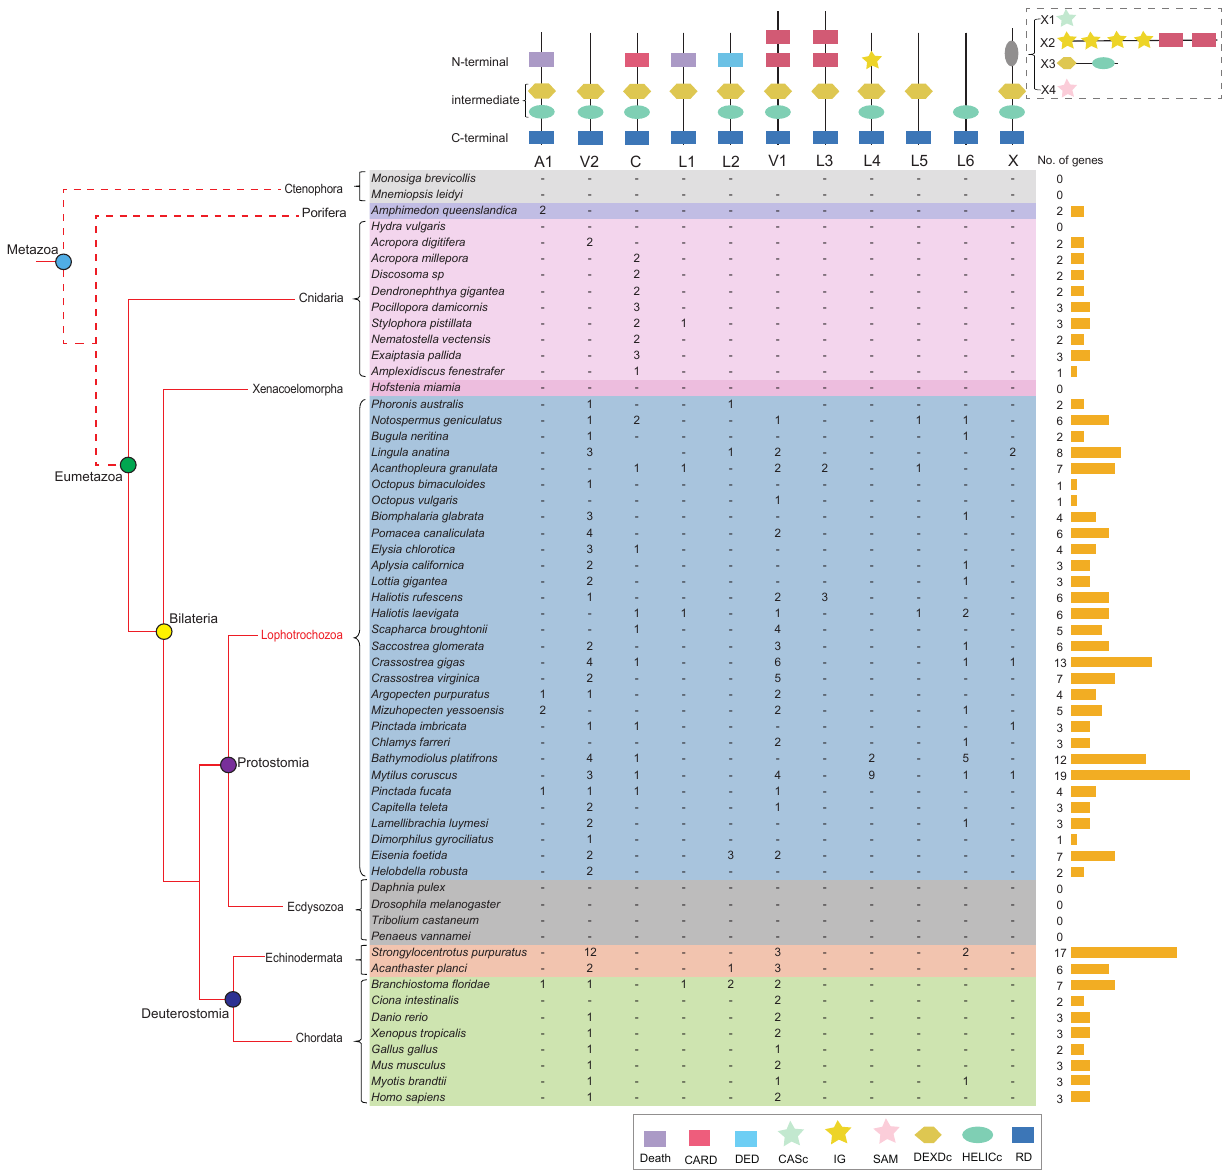
Argopecten purpuratus 1 1 - - - 2 - - - - - 4 Mizuhopecten yessoensis 2 - - - - 2 - - - 1 - 5 Pinctada imbricata - 1 1 - - - - - - - 1 3 Chlamys farreri - - - - - 2 - - - 1 - 3 Bathymodiolus platifrons - 4 1 - - - - 2 - 5 - 12 Mytilus coruscus - 3 1 - - 4 - 9 - 1 1 19 Pinctada fucata 1 1 1 - - 1 - - - - - 4 Capitella teleta - 2 - - - 1 - - - - - 3 Lamellibrachia luymesi - 2 - - - - - - - 1 - 3 Dimorphilus gyrociliatus - 1 - - - - - - - - - 1 Eisenia foetida - 2 - - 3 2 - - - - - 7 Helobdella robusta - 2 - - - - - - - - - 2 Daphnia pulex - - - - - - - - - - - 0 Drosophila melanogaster - - - - - - - - - - - 0 Tribolium castaneum - - - - - - - - - - - 0 Penaeus vannamei - - - - - - - - - - - 0 Strongylocentrotus purpuratus - 12 - - - 3 - -